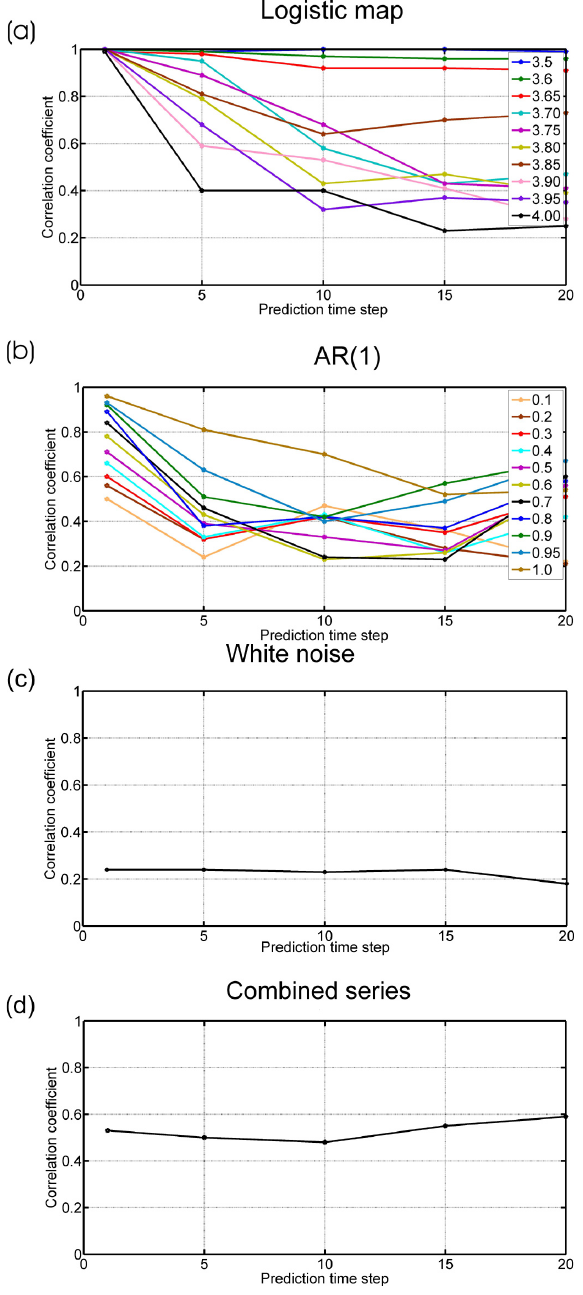
Fig. 4. (a) Plot of prediction time ahead and correlation coefficient of theoretical chaotic time series with different Maximum Likeli- hood Estimator (MLE) values. (b) Stochastic time series (control- ling parameter coefficient in a range of 3.5–4.0) (c) plot of predic- tion time ahead and correlation coefficient of random time series where mean = 0; standard deviation (STD = 1) (d) combined time series; random series (mean = 0; STD = 1) ;stochastic(Maximum Likelihood Estimator (MLE) constant = 0.5) and chaotic (control- ling parameter constant = 3.8).